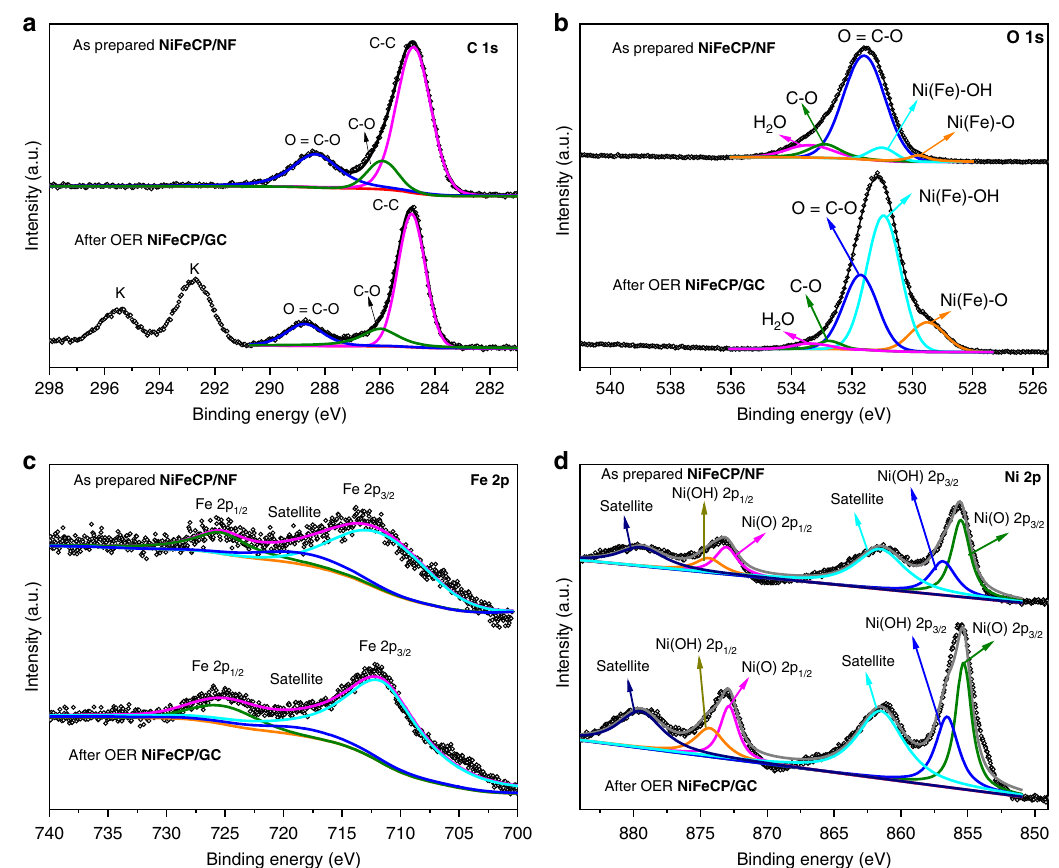
Fig. 4 XPS measurements. High-resolution XPS spectra of a C 1 s, b O 1 s, c Fe 2p, and d Ni 2p for the NiFeCP/NF electrode before and after OER